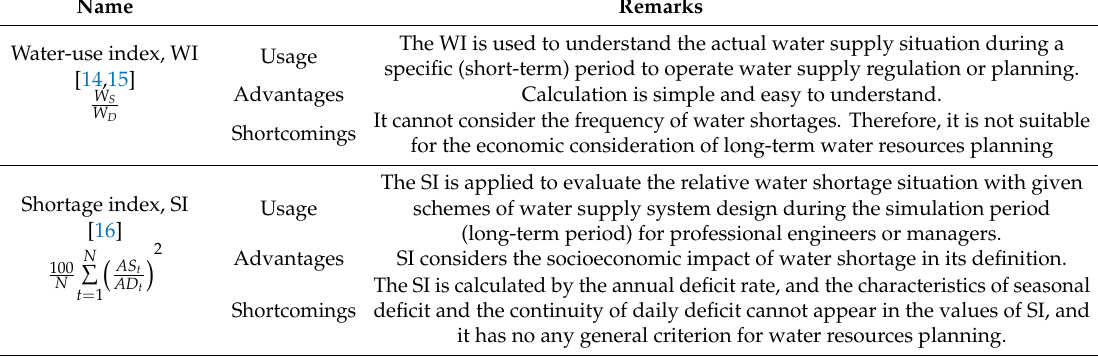
Table 2. The classification of water-use Index (The standard of Taiwan Water Corporation).